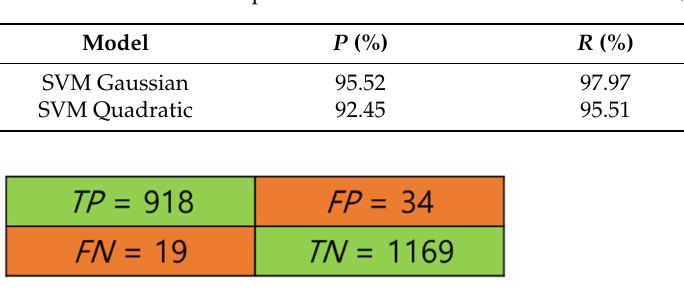
Table 3. Performance comparison between SVM-Gaussian and SVM-Quadratic.